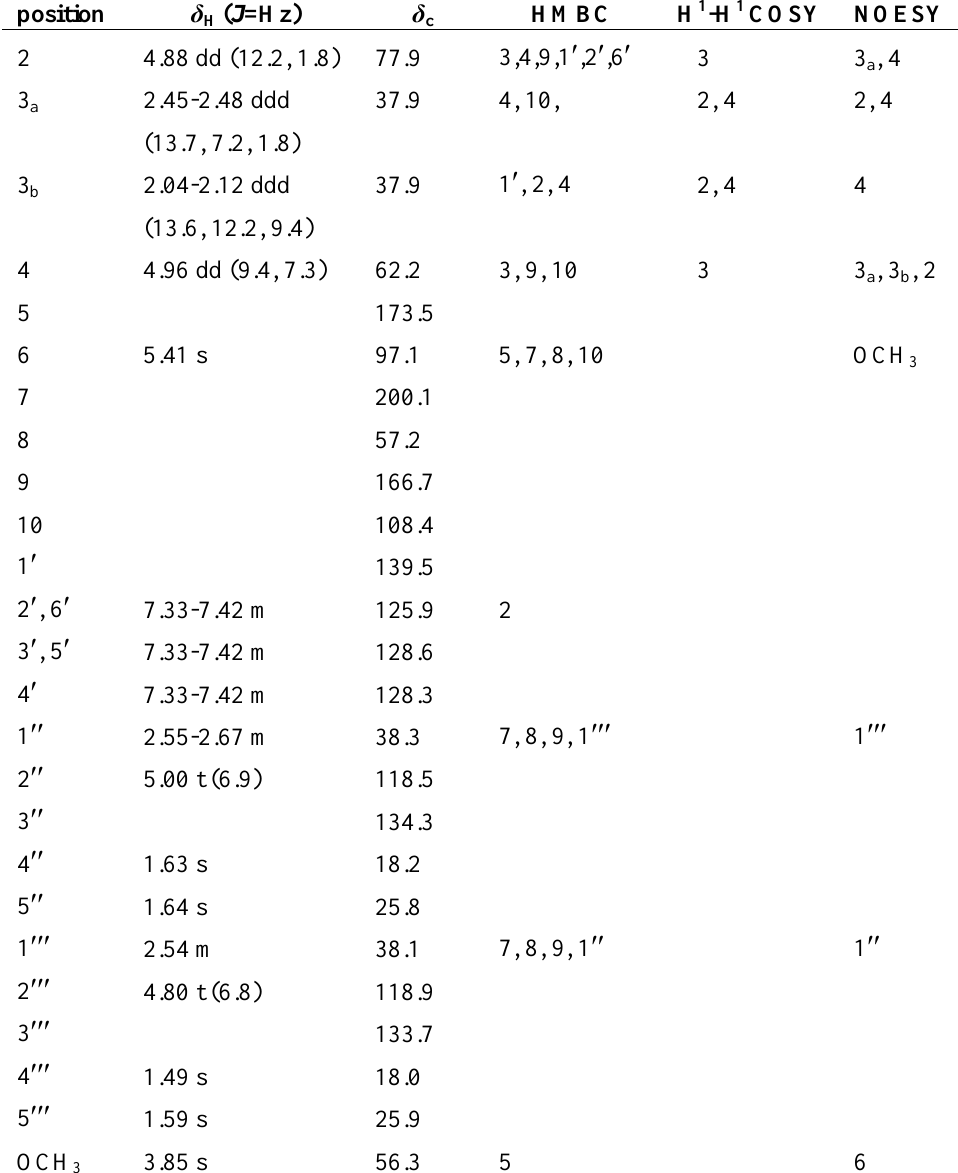
Table 1 . 1D- and Selected 2D-NMR spectral data of compound 1 a